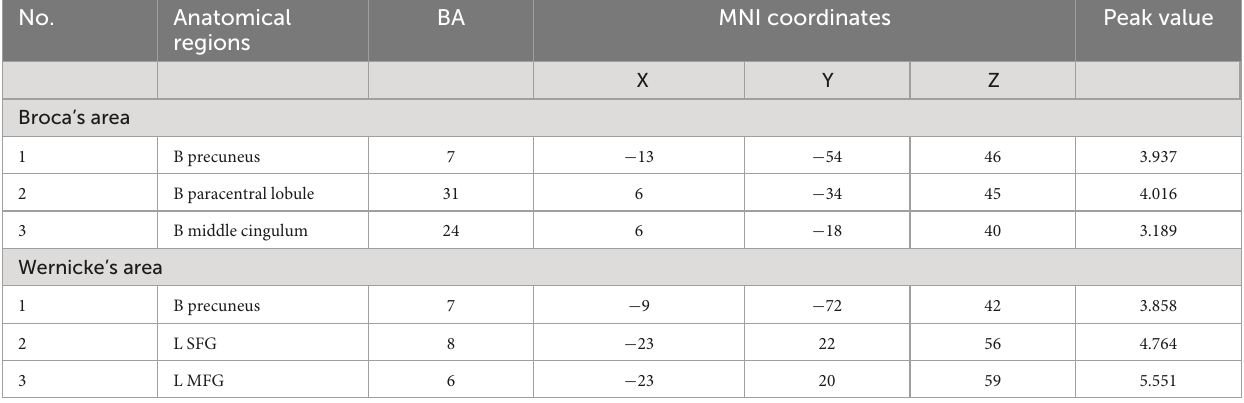
TABLE 3 The cerebral regions involved significant functional lateralization with regard to Broca’s and Wernicke’s areas (the seafarer group > the non-seafarer group; p 0.005, cluster size > 200 voxels, corresponding to corrected p FWE 0.05). No.